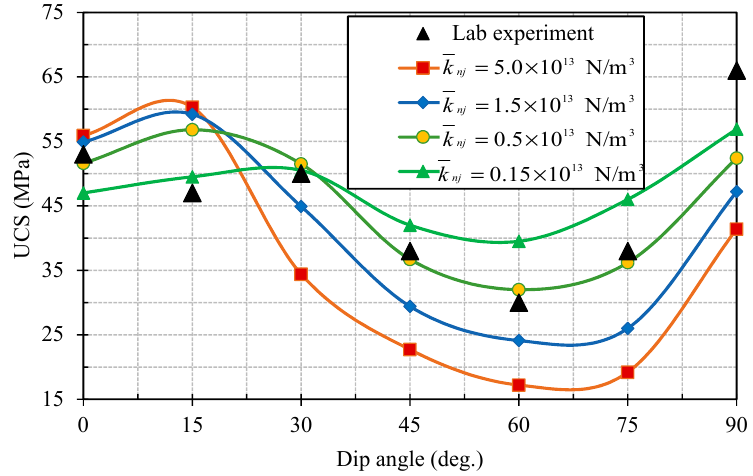
Figure 18. UCS variation of transversely isotropic rock samples with different joint normal stiffness.